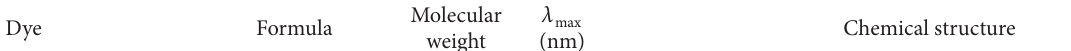
Table 2: Characteristics of dyes.